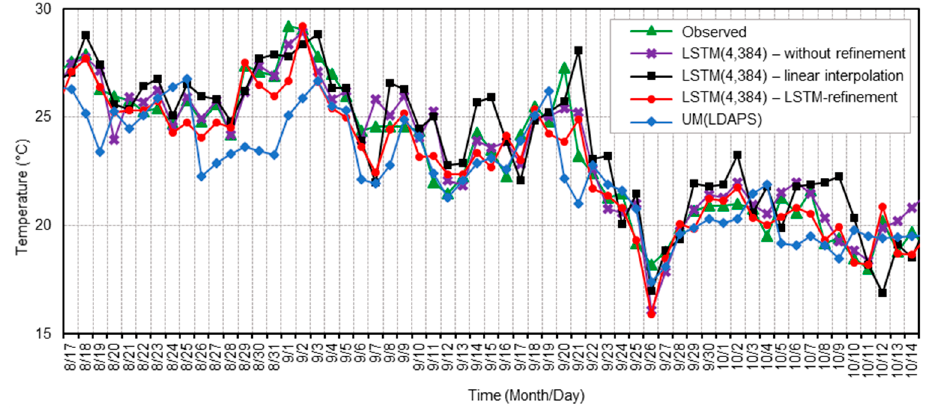
Figure 6. Daily basis plot of the observed and predicted temperature data for two months from August to October in Seoul, Korea for 24 h (1 day) prediction.